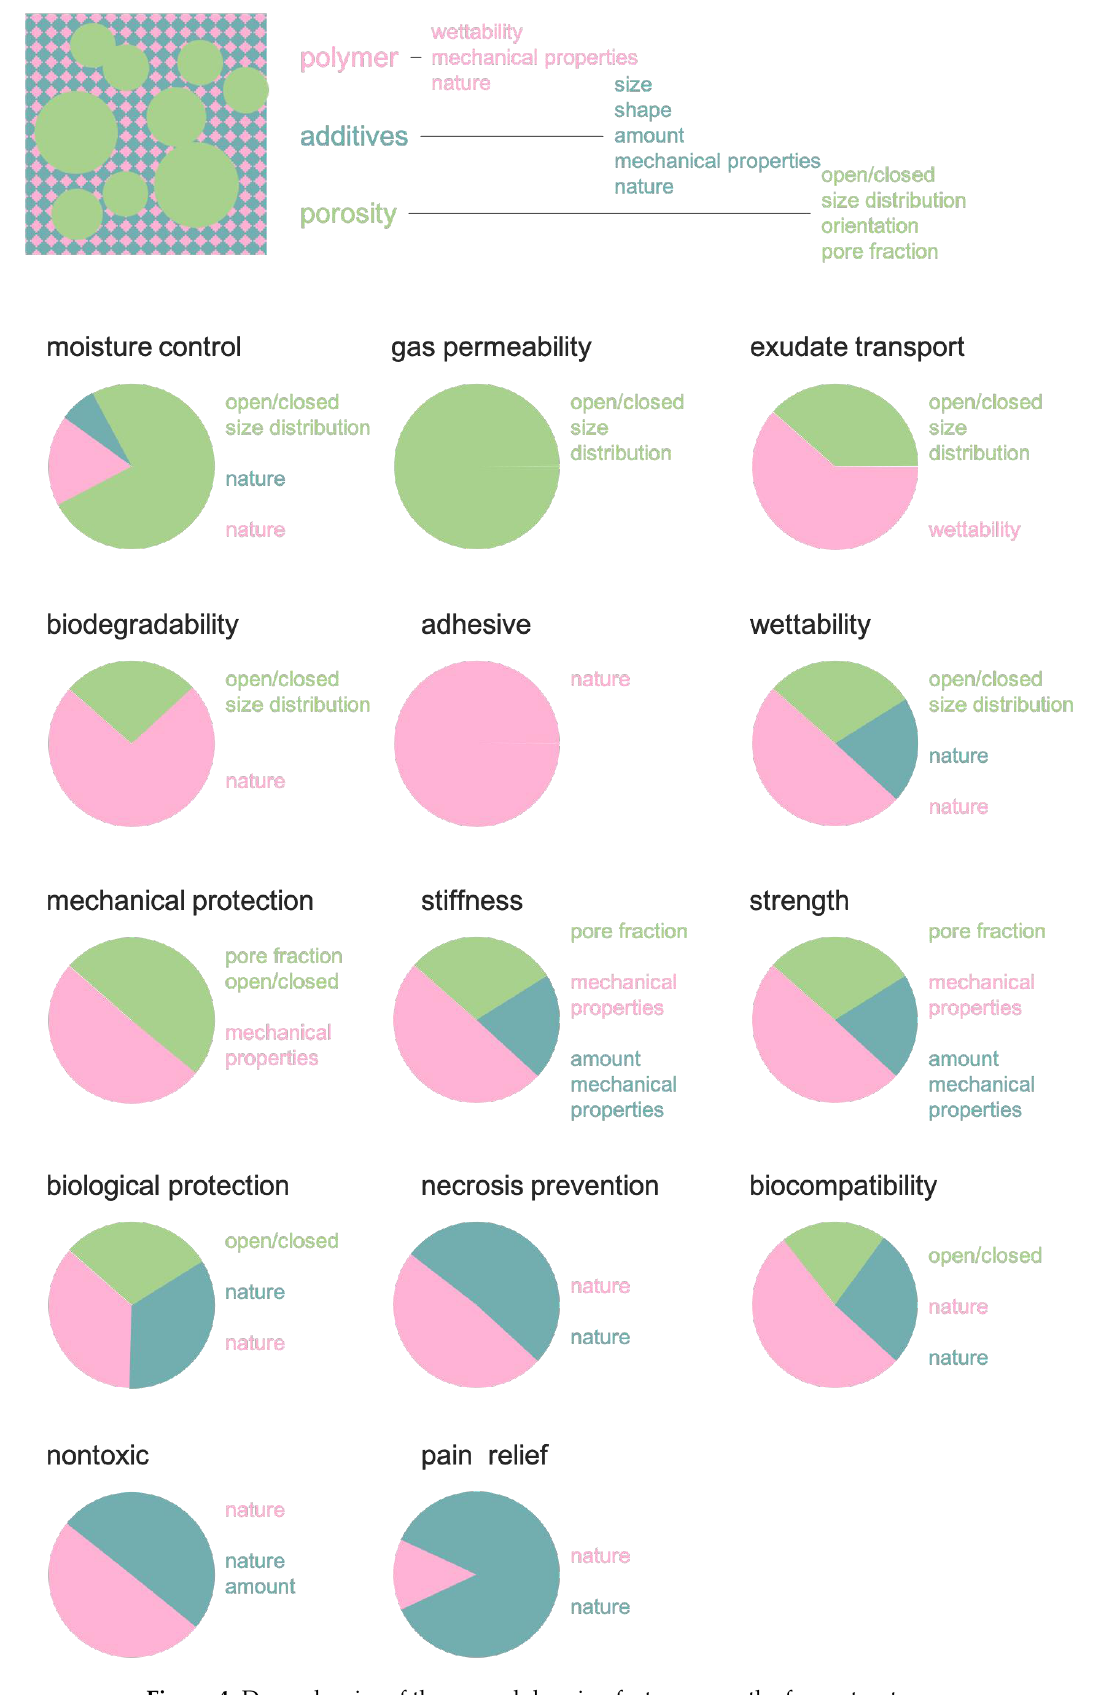
Figure 4. Dependencies of the wound dressing feature upon the foam structure.